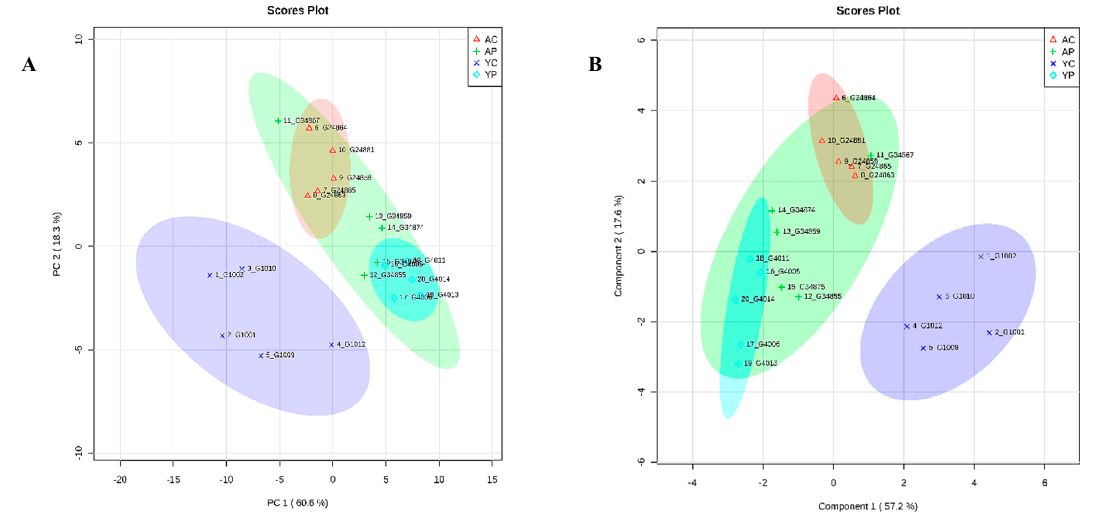
Figure 8. PCA plot ( A ) and PLS-DA plot ( B ) showing spatial division among all four groups. (YC) young control group, (YP) young probiotic group, (AC) aging control group, (AP) aging probiotic group.